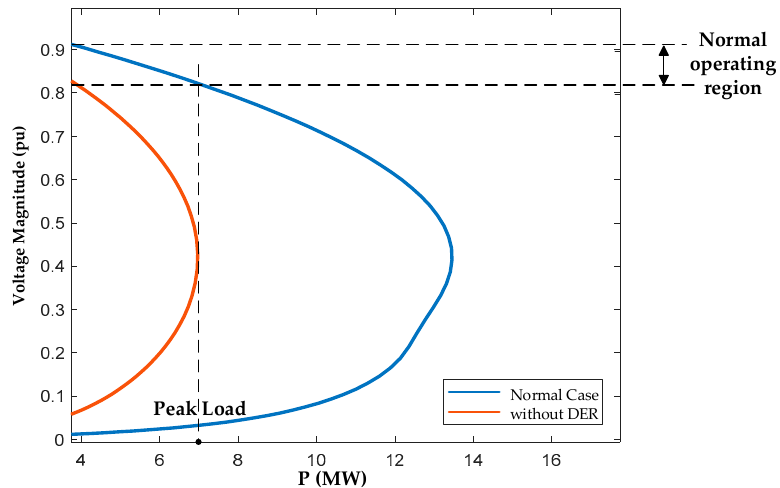
Figure 8. Comparison of the saddle-node bifurcation around the DER hosting capacity (5.60 MW).